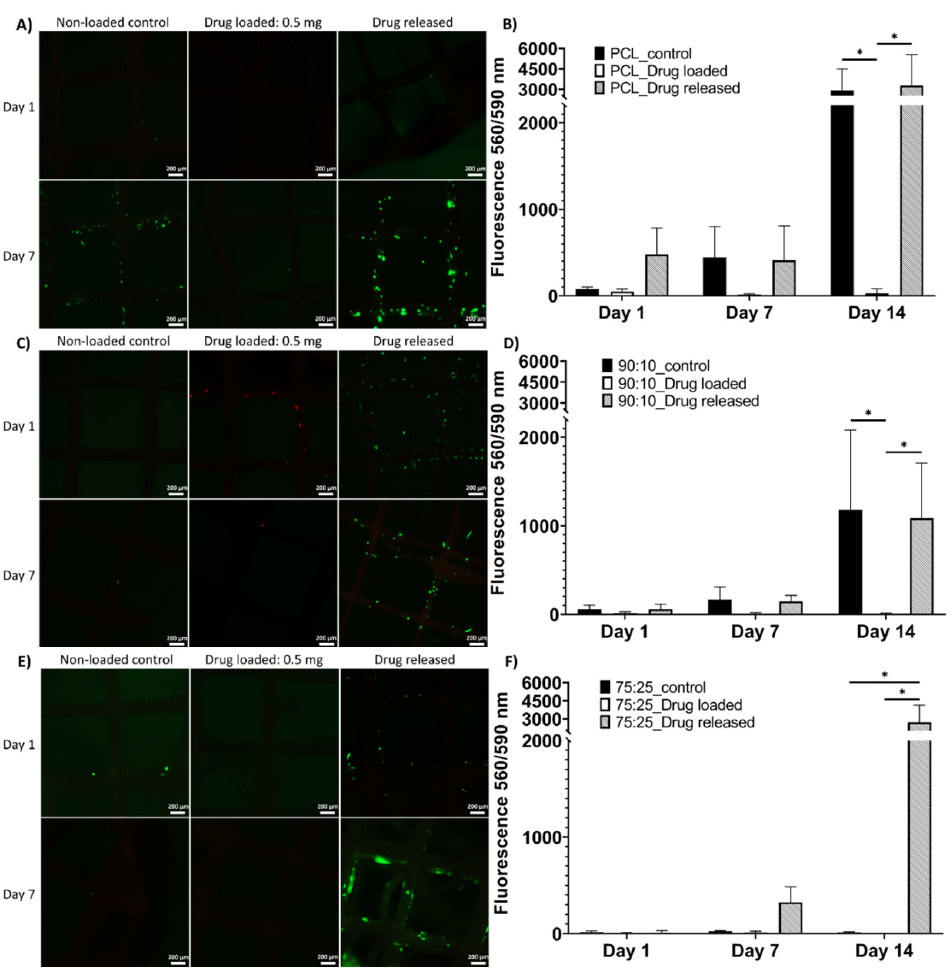
Figure 6. LIVE/DEAD assay and alamarBlue assay of all sample groups at all assessment time points. LIVE/DEAD assay results (( A ) for PCL meshes, ( C ) for 90:10 meshes, ( E ) for 75:25 meshes) showing viable cells in green fluorescence. AlamarBlue results (( B ) for PCL meshes, ( D ) for 90:10 meshes, ( F ) for 75:25 meshes) show mean± standard error mean (scale = 200 µm). In graph B and graph